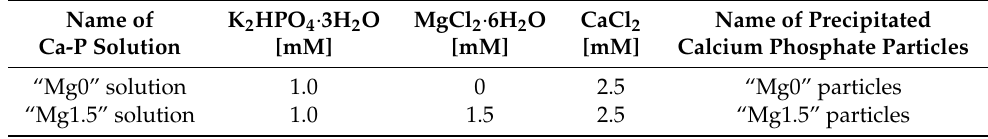
Table 1. Name of solutions, concentration of the dissolved reagents in each Ca-P solution, and name of the precipitated calcium phosphate